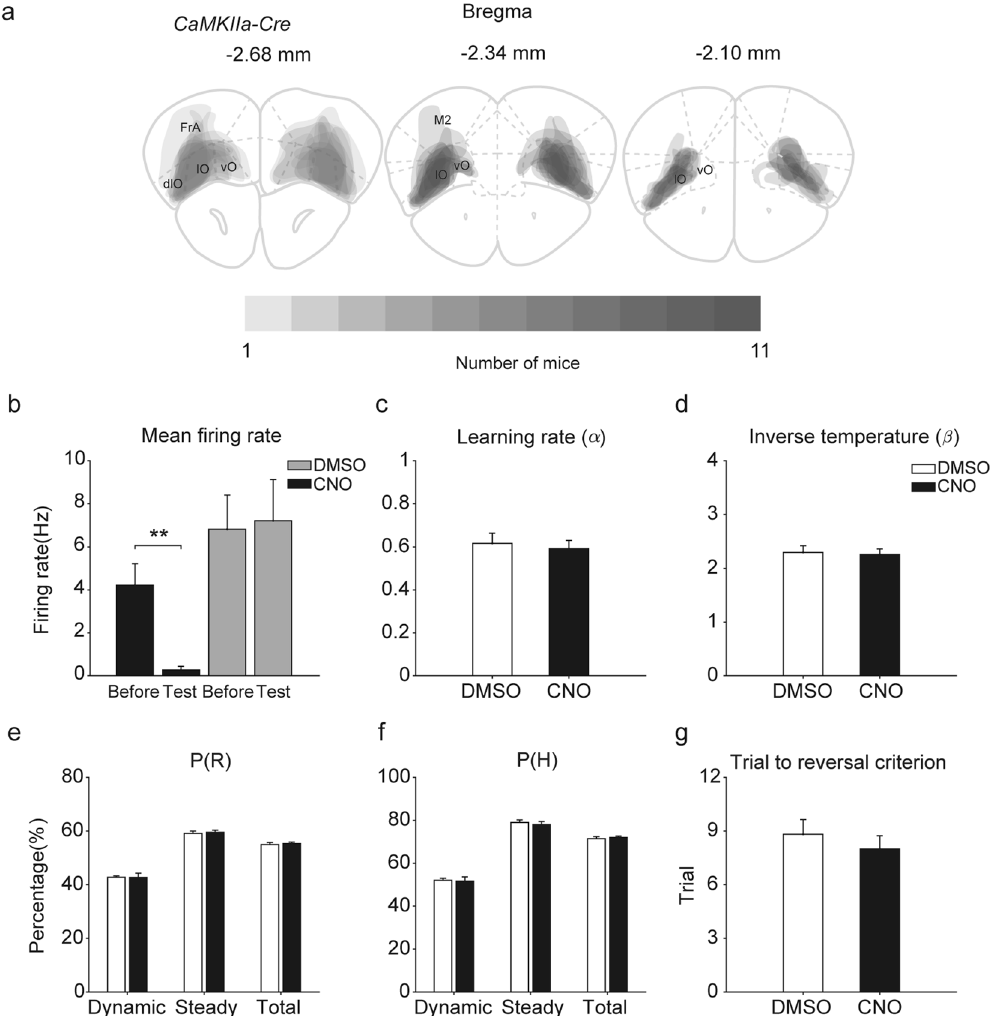
Figure 8. Effects of OFC inactivation. ( a ) Histological results. The extents of hM4Di expression are shown overlaid for all mice used for OFC inactivation (n = 11; coronal section views). Dark color indicates overlapping areas across animals. ( b ) CNO-induced suppression of OFC neuronal activity. ( c , d ) Effects of OFC inactivation on learning rate and inverse temperature. ( e – g ) Effects of OFC inactivation on choice